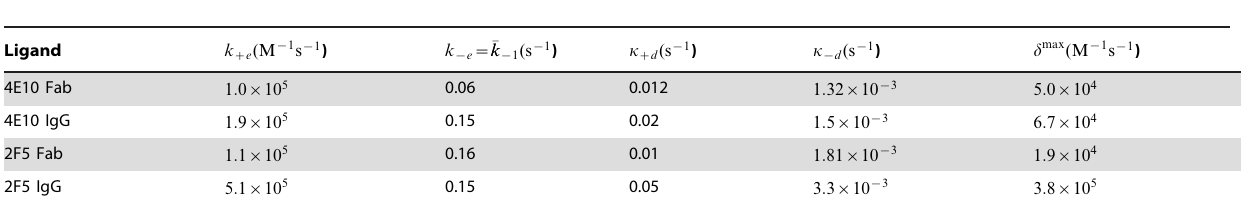
Table 2. Parameters used to calculate p b